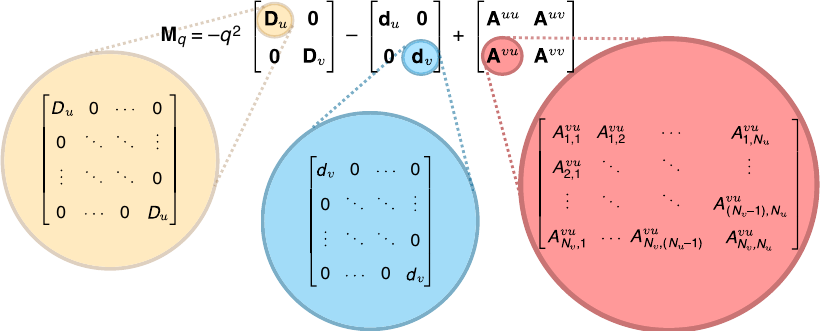
Fig. 1 The structure of the stability matrix M q . The matrix is composed of three parts: a diffusion matrix D , a self-interaction matrix d , and an interaction matrix A with entries drawn at random from a probability distribution. Each matrix is split into blocks due to the trophic structure of the community — we use the subscript u to denote species which have mostly prey-like interactions and v for species with mostly predator-like interactions. The approach can be generalised to more complicated block structures. The stability of the non-spatial ecosystem is described by the matrix for q = 0, or equivalently by setting D = D = 0 (see Methods and Section S1 in the Supplementary u v